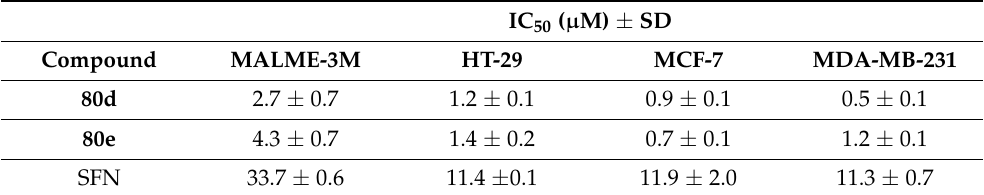
Figure 21. Synthesis of fluoroaryl and fluoroarylmethyl analogs 80a – h . All fluoroaryl and fluoroarylmethyl analogs 80a – h were tested in vitro for their anti- cancer, antibacterial, antifungal, and antiviral properties. The anticancer activity on the skin cancer cell line (MALME-3M), colon cancer cell line (HT-29), and breast cancer cell lines (MCF-7 and MDA-MB-231), as well as their normal cell lines, were studied. After 72 h of incubation, all compounds presented higher activity than SFN. The most active on all cancer cell lines were ITCs 80d and 80e (Table 3). Table 3. The IC 50 ( µ M) for 80d and 80e and SFN after 72 h of incubation (mean ±